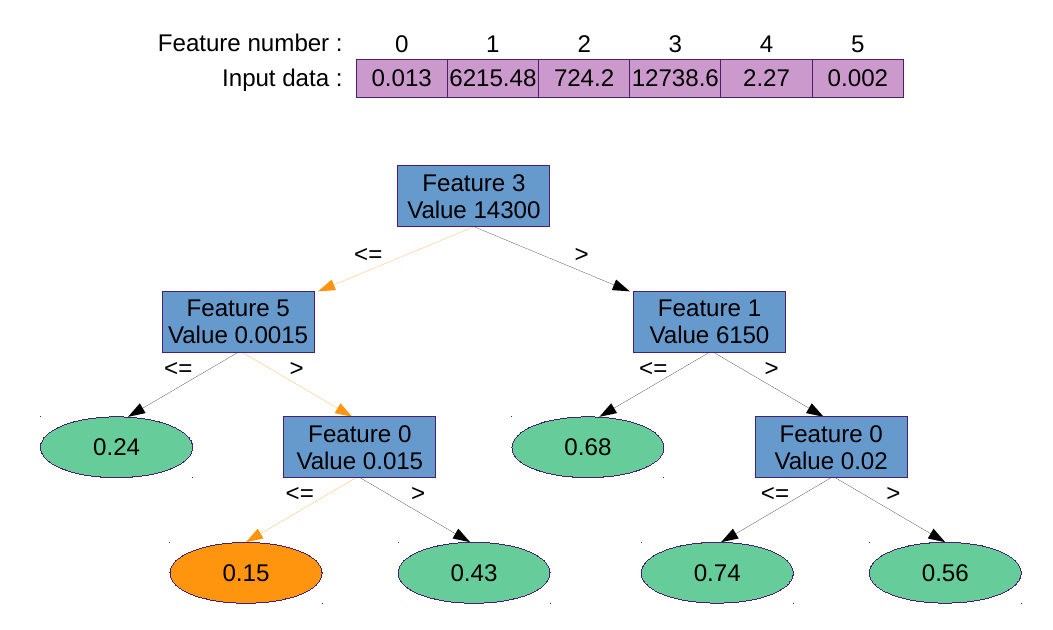
Figure 1. Decision tree